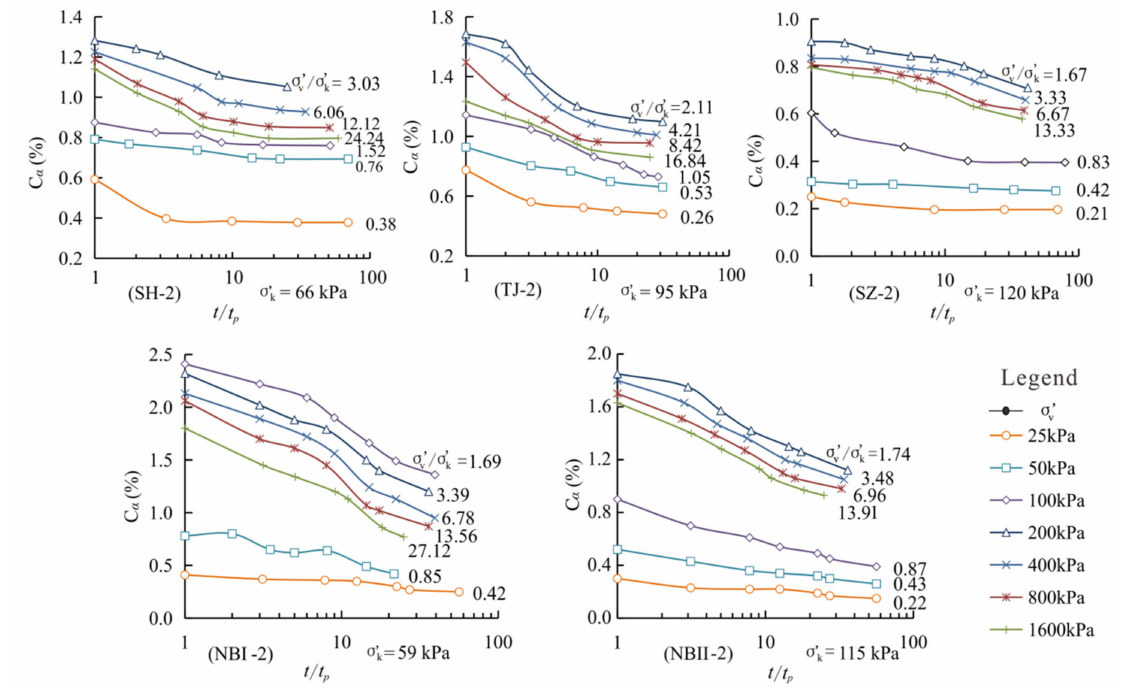
Figure 12. Variations of secondary compression coe ffi cient C α with